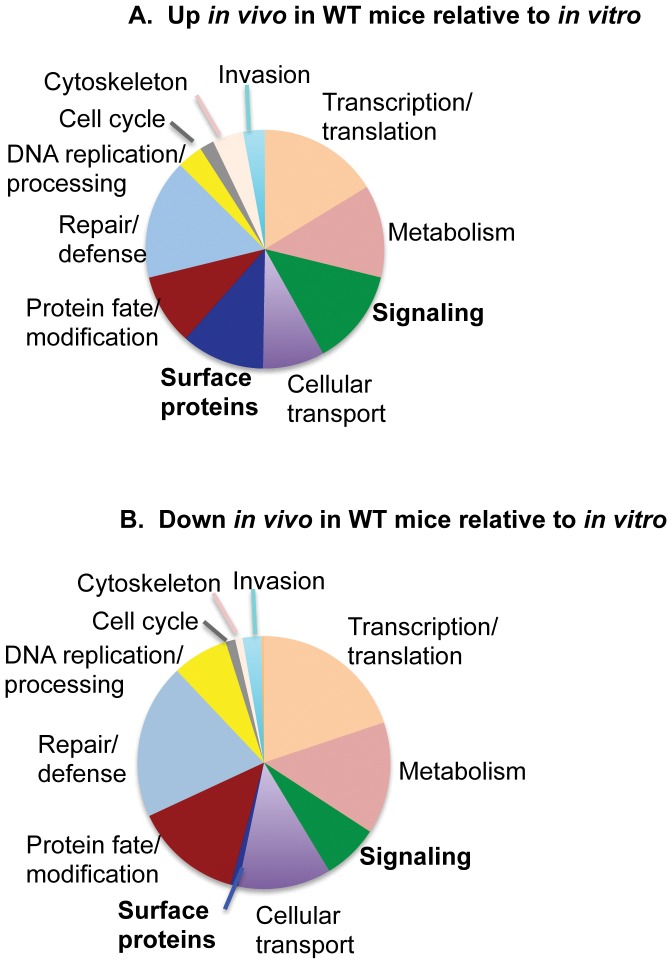
Functional categorization of T. gondii genes with increased or decreased expression in WT mice compared to in vitro in HFF cells.A. Functional categorization of genes increased in vivo in WT mice compared to in vitro, B. Functional categorization of genes decreased in vivo in WT mice compared to in vitro. 68% of the genes up in WT mice and 51% of the genes down in WT mice are of unknown function and are not included.